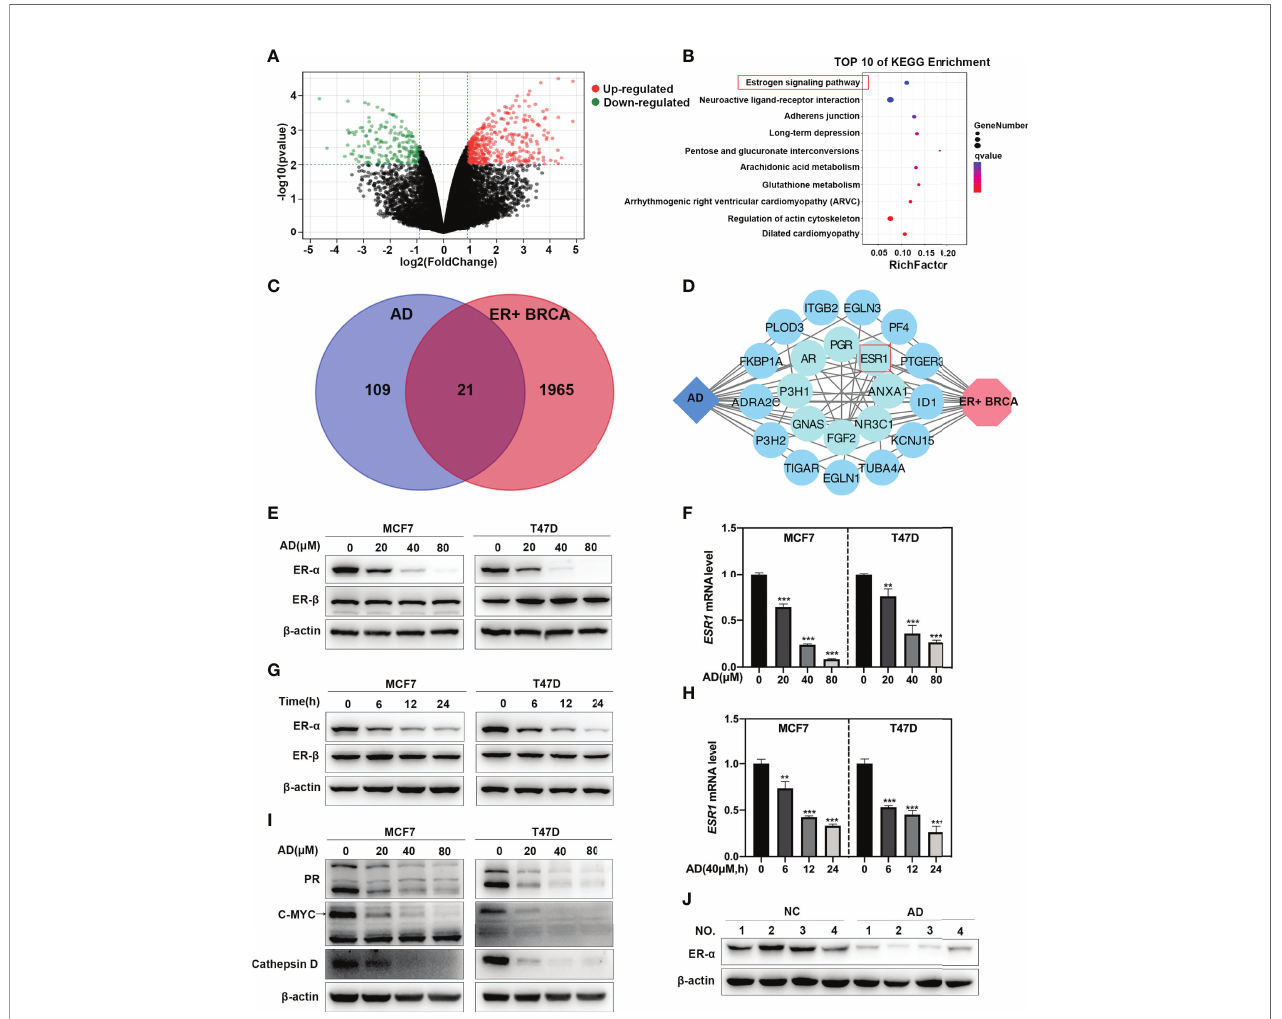
FIGURE 1 | AD inhibits ESR1 transcription in ER-positive breast cancer. (A) Volcano plot showing the DEGs between the control and AD treatment group from the GSE85871 dataset. (B) KEGG pathway enrichment analysis for the DEGs and qvalue refers to -log 10 (pvalue). (C) Venn plot revealing the overlapping target genes for AD against ER-positive breast cancer. Blue circle represents AD; red circle represents ER-positive breast cancer. (D) Network of target genes for AD against ER- positive breast cancer was built using the STRING database and Cytoscape software. Blue diamond represents AD; red hexagon represents ER-positive breast cancer; blue circles represent target genes of AD in ER-positive breast cancer and were arranged from the inner circle to the outer circle according to the degree of association. (E) Cells were treated with 1 ‰ DMSO or the indicated concentrations of AD for 24 h. Cell protein was extracted and detected by Western blotting with antibodies against ER- a , ER- b and b -actin. (F) The mRNA level of ESR1 was quanti fi ed by RT-PCR (normalized to b -actin). (G) Cells were treated with AD (40 m M) for 0 h, 6 h, 12 h, 24 h, respectively. Cell protein was extracted and detected by Western blotting with antibodies against ER- a , ER- b and b -actin. (H) The mRNA level of ESR1 was quanti fi ed by RT-PCR (normalized to b -actin). (I) Cells were treated with 1 ‰ DMSO or the indicated concentrations of AD for 24 h. Cell protein was extracted and detected by Western blotting with antibodies against PR, C-MYC, Cathepsin D and b -actin. (J) Proteins extracted from tumor tissues of mice treated with 20% HPBCD or AD (150 mg/kg) were detected by Western blotting with antibodies against ER- a and b -actin. (Data were presented as mean ± SD. ** P < 0.01 and *** P <